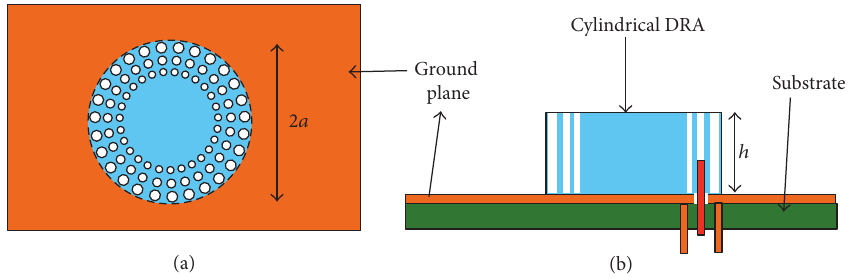
Figure 20: Top (a) and cross-sectional view (b) of a perforated DRA as suggested in [46].